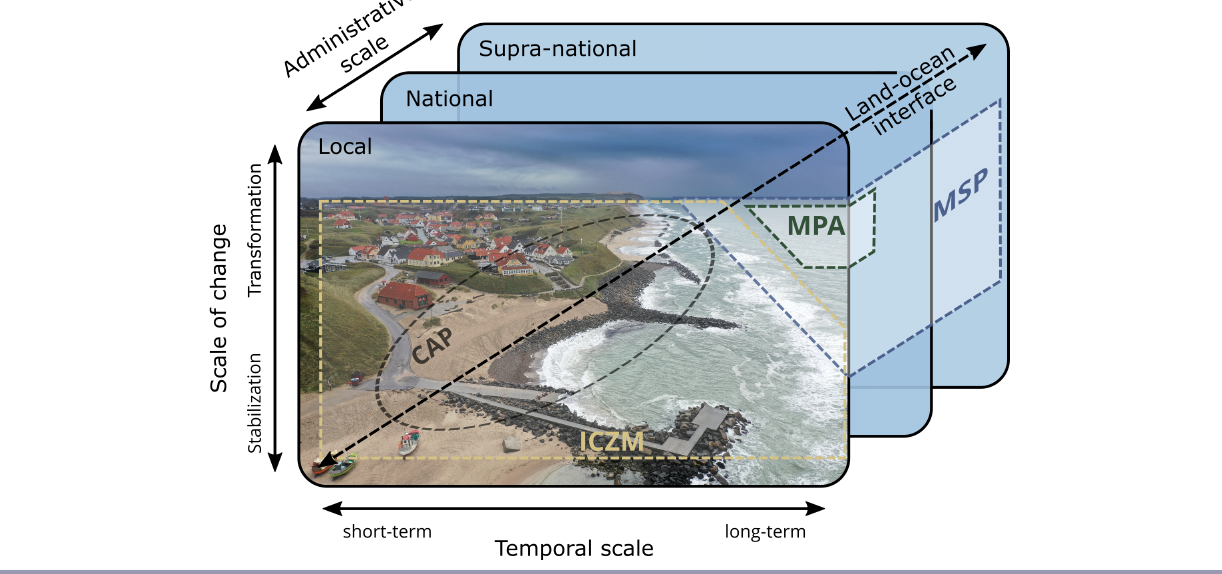
Fig. 3 . Identifying key scales and boundaries in coastal social-ecological systems across which resilience has to be managed. The spatial scale includes both the land-ocean interface, as well as the connection between SES along different spatial scales. Different area-based management approaches such as Marine Spatial Planning (MSP), Integrated Coastal Zone Management (ICZM), and Marine Protected Areas (MPA) are thereby applied within different spatial extents and at different administrative levels (local, national, supra-national). Additionally, Climate Adaptation Planning (CAP) is of relevance for coastal governance at the local scale. The temporal scale is dependent on the system's characteristics and target and may vary between short- and long-term planning. Linked to the temporal scale is the scale of change, which is characterized by a navigation between stabilization and transformation. Aerial photograph used with permission by Lisa